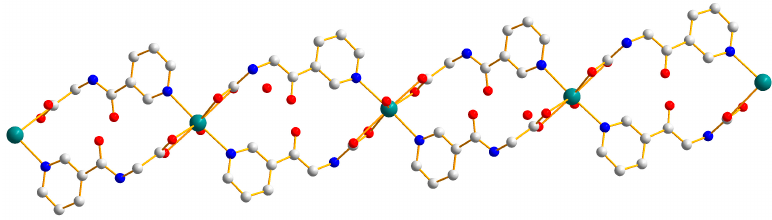
Figure 2. One-dimensional chained structure by the bridging of ligands.